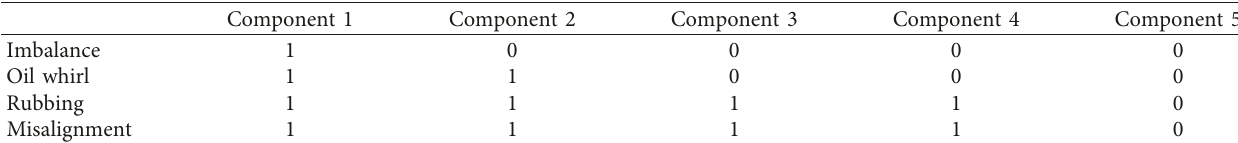
Table 3: Results of K-L divergence-based HVD component